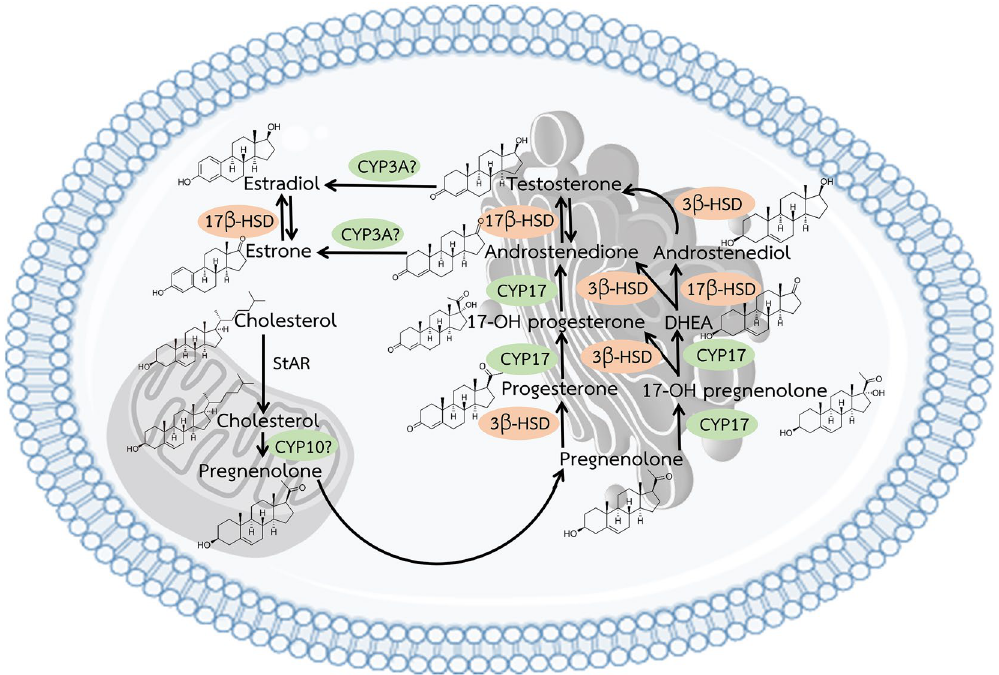
Figure 2. Schematic diagram showing the putative pathway for steroidogenesis in the H. scabra between mitochondria and the smooth endoplasmic reticulum (SER) . In the pathway of steroid hormone biosynthesis, there are two major types of enzymes: cytochromes P450 (green) and other hydroxysteroid dehydrogenases (orange). In H. scabra , we identified gene transcripts encoding steroidogenic acute regulatory protein (StAR), cytochrome P450 10 (CYP10), 17alpha-hydroxylase/17, 20-lyase (CYP17), cytochrome P450 3A (CYP3A), 3beta-hydroxysteroid dehydrogenase (3β-HSD), and 17beta-hydroxysteroid dehydrogenase (17β-HSD). Question marks remain unclear. Steroidogenesis begins in the cells where cholesterol transport into the mitochondria facilitated by StAR. Once in the mitochondria, cholesterol may be converted to pregnenolone through the action of CYP10. Pregnenolone then diffuses to the SER, where it is further converted into a series of reactions to testosterone. Testosterone may be subsequently aromatized to estradiol through the action of